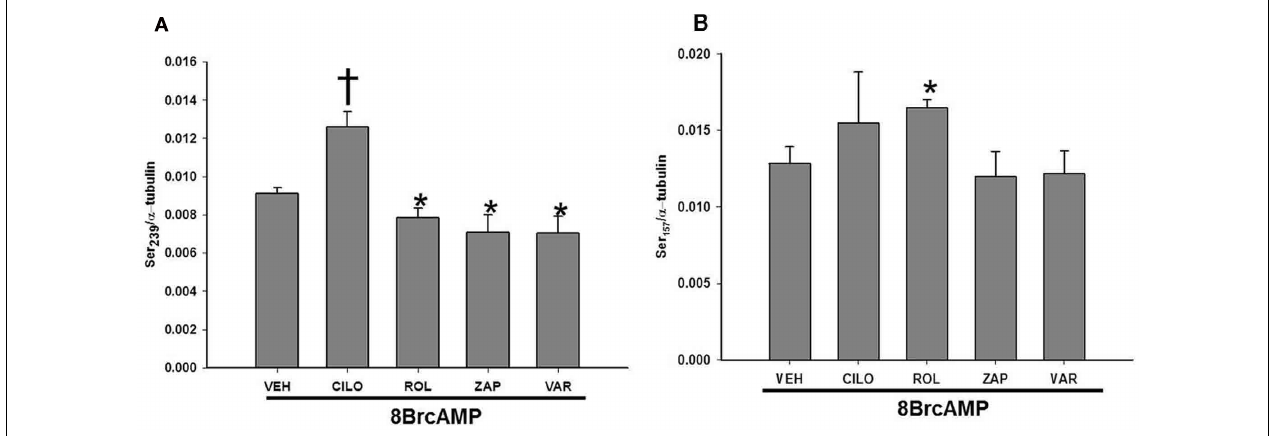
( P < 0.05). (B) Effect of inhibitors of PDEs on 8Br-cAMP-inducedVASPSer 157 phosphorylation.VSMCs treated with 8Br-cAMP (10 μ M) in the absence or presence of cilostazol (CILO, 10 μ M), rolipram (ROL, 10 μ M), zaprinast (ZAP, 10 μ M), or vardenafil (VAR, 50nM), ( n = 3).Values are the means ± SE. *Different from vehicle control